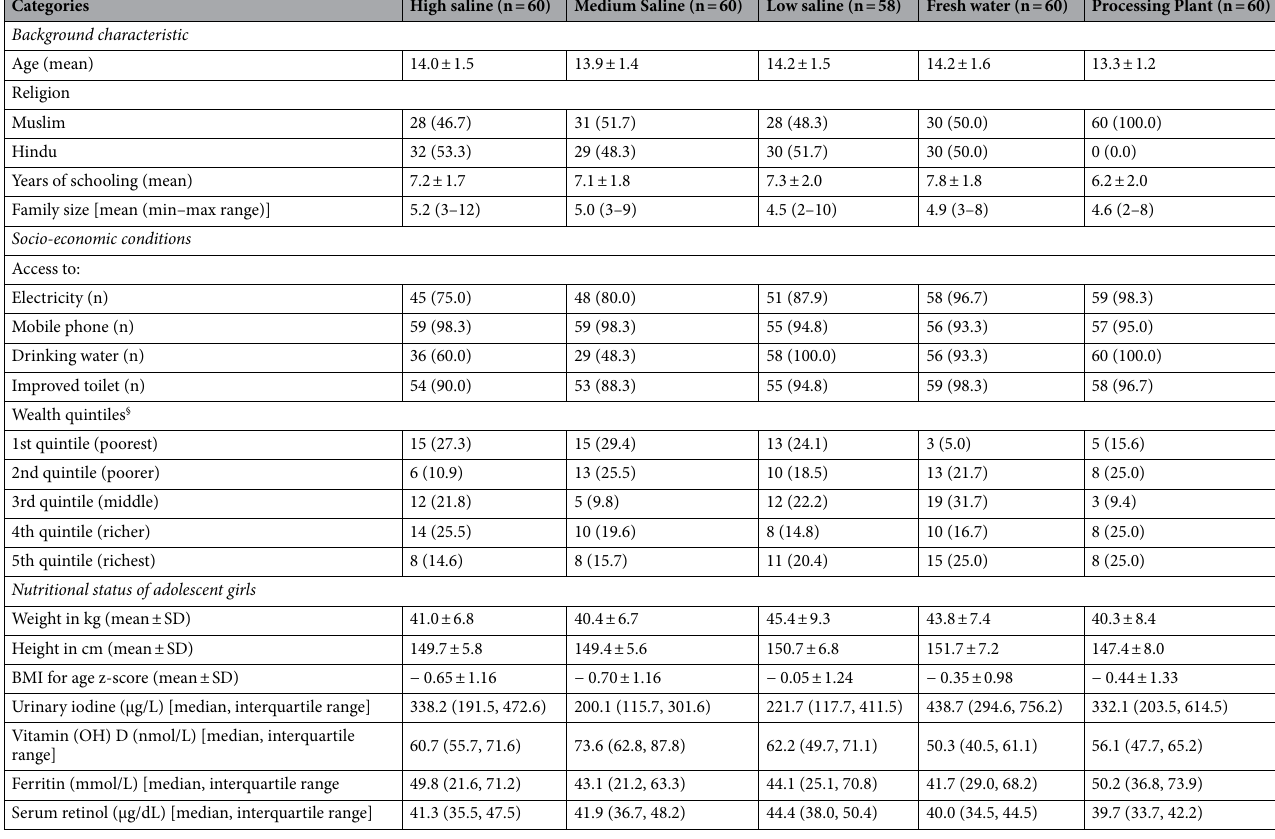
Table 1. Background characteristics and nutritional status of adolescent girls by the salinity areas at the first survey round (dry season). BMI Body Mass Index, SD Standard Deviation. § Wealth quintile defined by the entire sample (n =